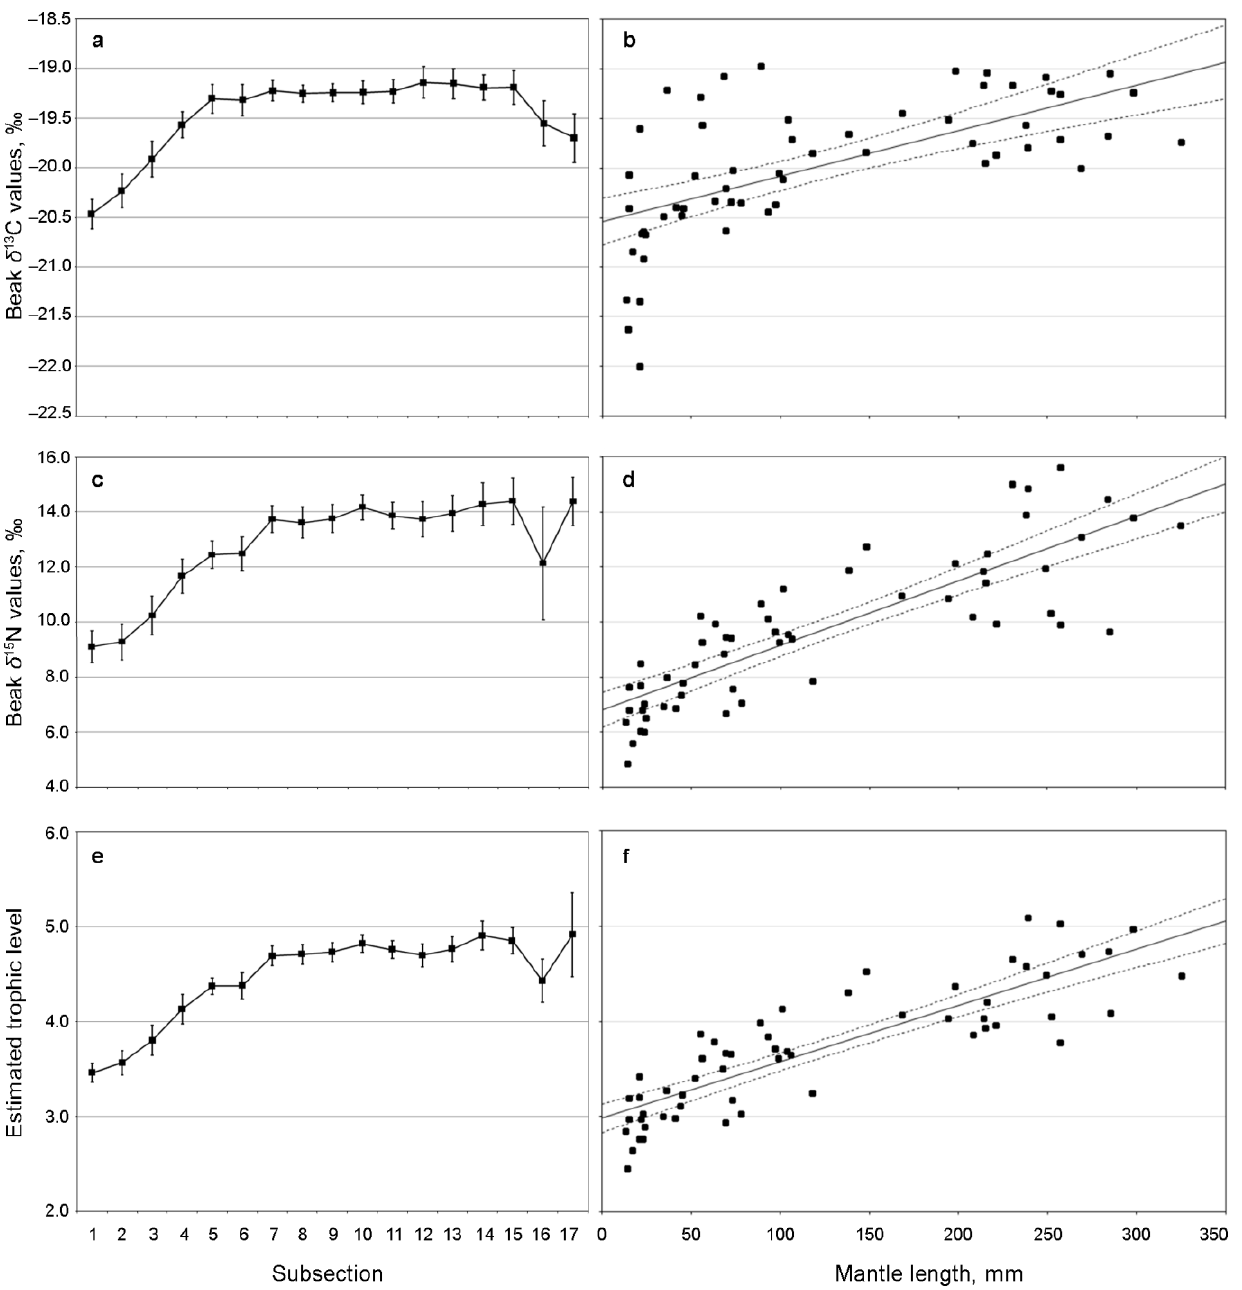
Figure 3. Ontogenetic changes in δ 13 C and δ 15 N values, and trophic level (TL) in Gonatus fabricii from West Greenland at the individual ( a , c , e ) and population ( b , d , f ) levels: ( a ) δ 13 C, individual level, ( b ) δ 13 C, population level, ( c ) δ 15 N, individual level, ( d ) δ 15 N, population level, ( e ) TL, individual level, and ( f ) TL, population level. Filled squares represent mean value at given subsection ( a , c , e ) or individual values ( b , d , f ). Bars ( a , c , e ) represent